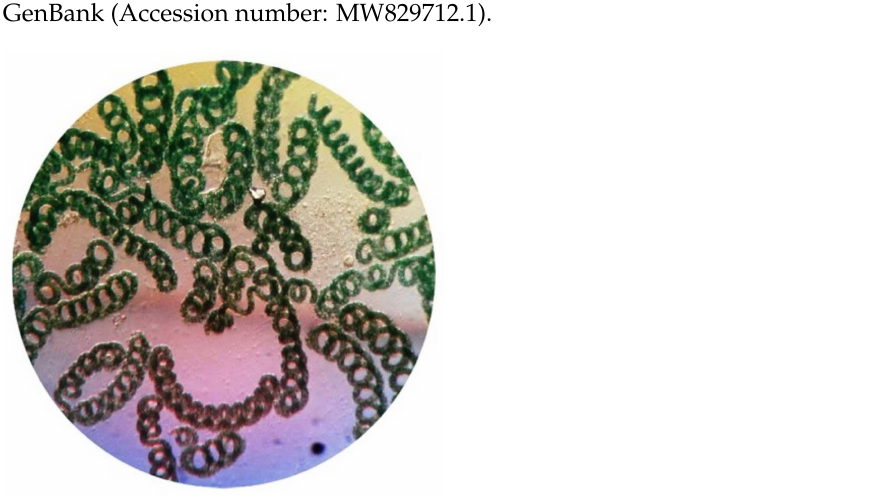
Figure 2. Shows the morphological structure of Spirulina laxissima SV001 under light microscope (40 ×